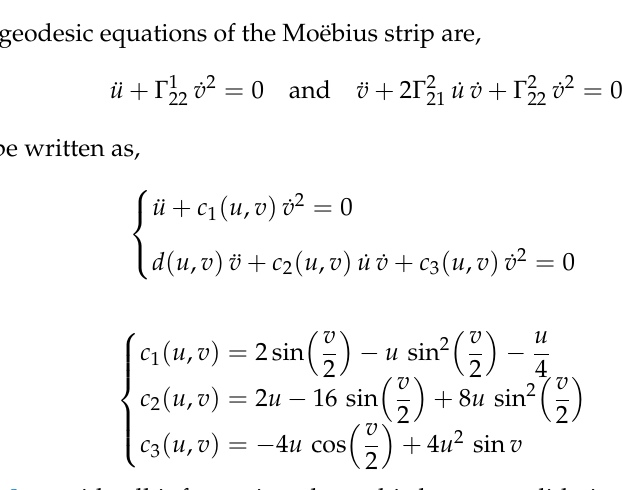
Figure 9 provide all information about this last test validation case. Table 2 details